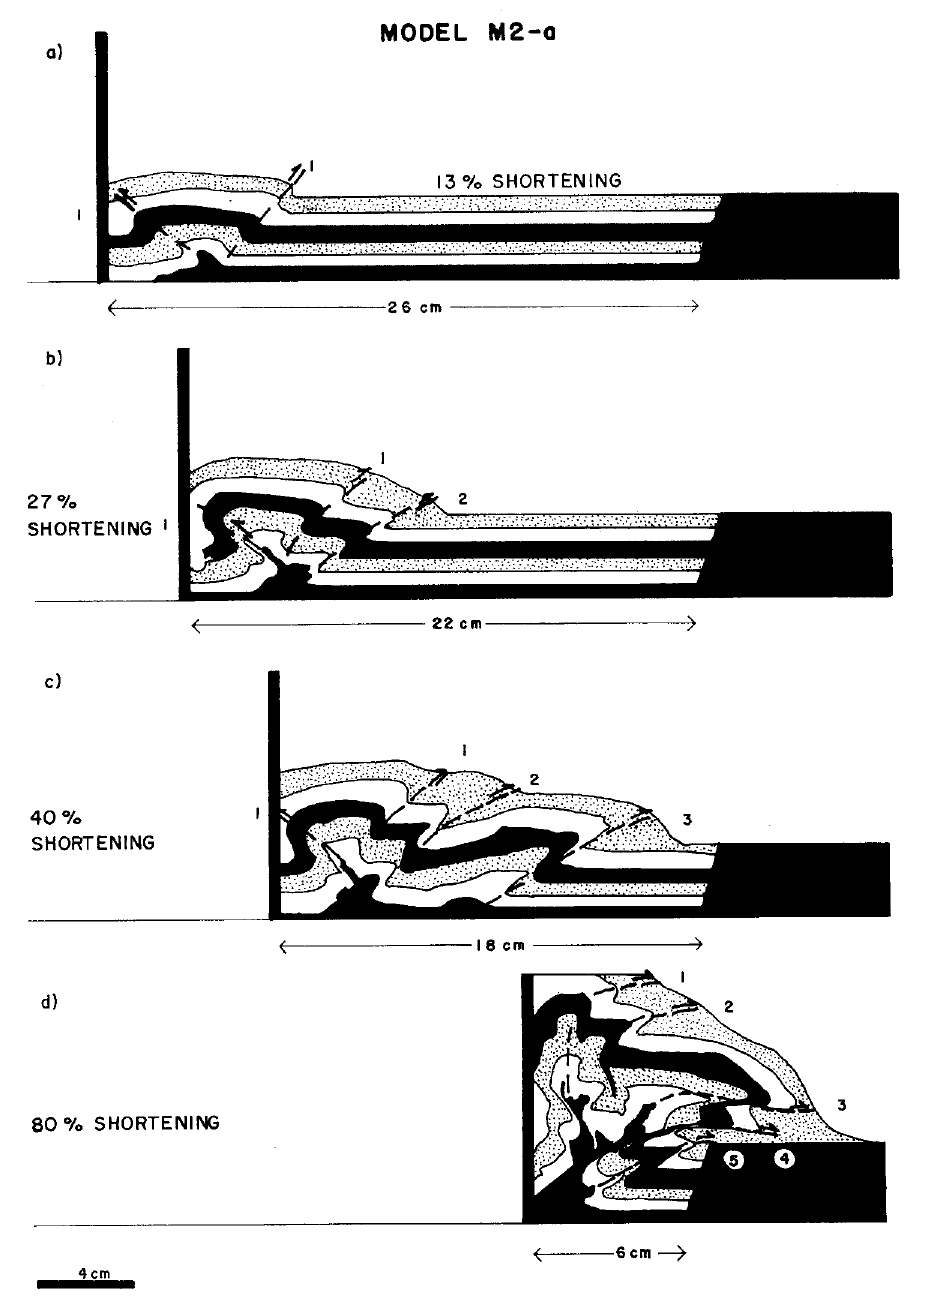
Fig. 9 – Four successive stages of model M2-a (small obstacle and rigid backstop). The antiformal stack evolution of this model is very similar to model M1-a. After (a) 13%; (b) 27%; (c) 40%; and (d) 80% shortening. Different structures, due to the obstacle height, appear only in (d).